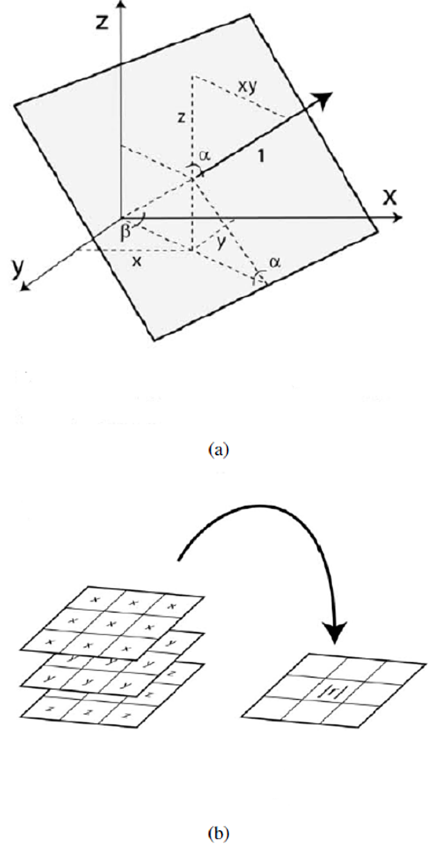
Figure 4. Calculation of vector ruggedness measure R . (a) Decom- position of normal unit vectors of a DTM grid cell into x , y and z components using slope α and aspect β . (b) Resultant vector r is obtained by summing up the x , y and z components of all pixels n within the neighbourhood window. Graphics from Sappington et al. (2007).